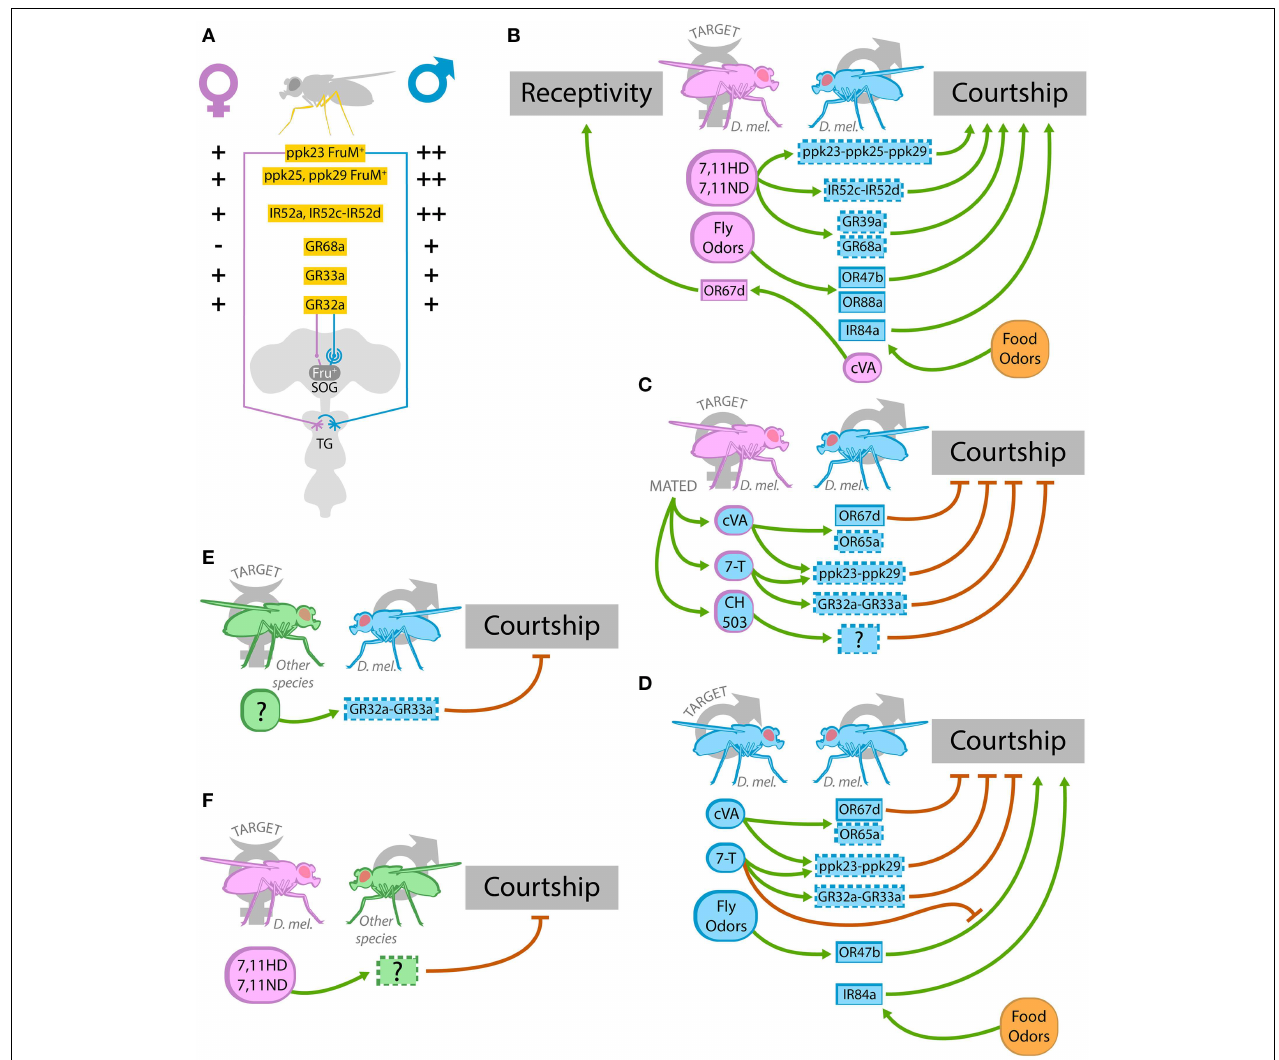
from males to females during mating. 7-T deposited on courted females apparently activates GR32a-GR33a and ppk23-ppk29 + neurons in the male leg and concomitantly reduces courtship by other males. cVA transferred to mated females activates OR67d and presumably OR65a in the male antenna, and probably ppk23-ppk29 + neurons in the male leg, leading to courtship inhibition. CH503 acts through unknown receptors and also leads to a reduction of courtship. (D) In a male-male encounter, cVA and 7-T inhibit homosexual courtship acting through OR67d, OR65a in the antenna and presumably ppk23-ppk29, GR32a-GR33a complexes in the leg. The courtship-promoting signal that follows the activation of OR47b by fly odors is inhibited by 7-T. Food odors activate IR84a and promote male-male courtship. To simplify, only the signals emitted by one of the males are shown in the drawing but the reciprocal ones are also present in the encounter. (E) Unidentified cuticular hydrocarbons of females of other Drosophila species ( D. simulans , D. yakuba , and D. virilis ) are most likely sensed by GR32a-Gr33a in D. melanogaster males and this prevents interspecific courtship. (F) The female hydrocarbons 7,11 HD and 7,11 ND act through unknown chemoreceptors in males of other Drosophila species ( D. simulans , D. yakuba , and D. erecta ) and inhibit courtship. In panels (B–F) , pink stands for female, blue, male, and green, male or female of another Drosophila species. In the boxes, a full-lined frame indicates that the protein is a bona fide chemoreceptor, while a dotted-line means that there is still no clear demonstration of the protein’s role as